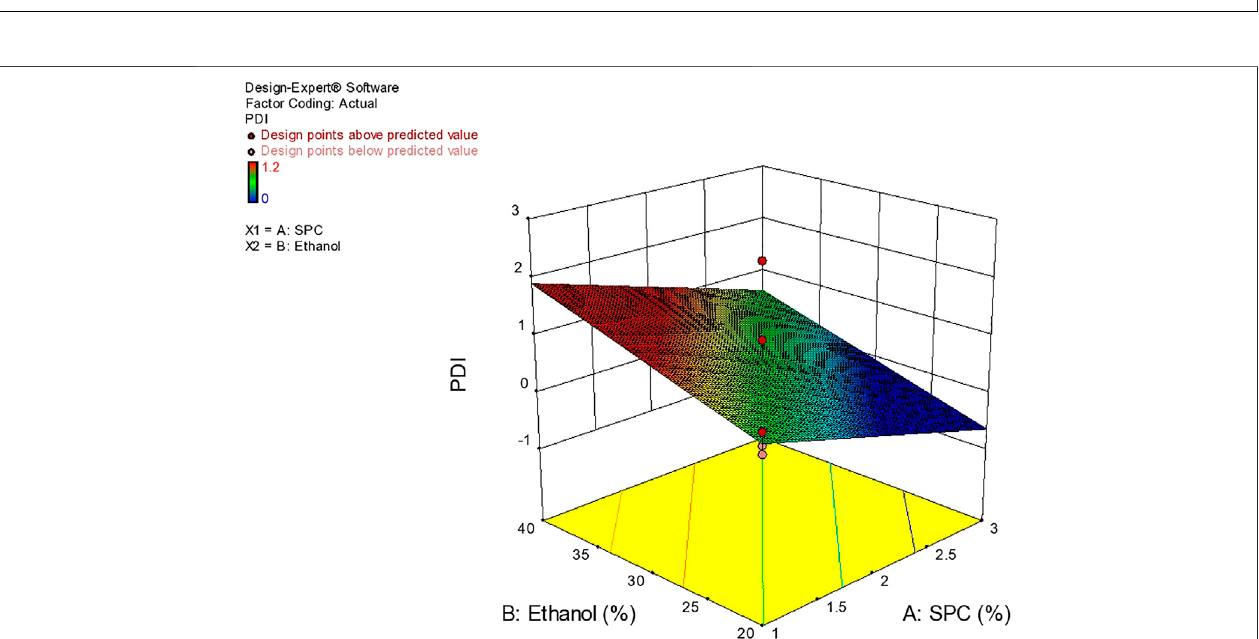
FIGURE 7 | Response surface plots showing effect of lipid and ethanol on Zet potential.